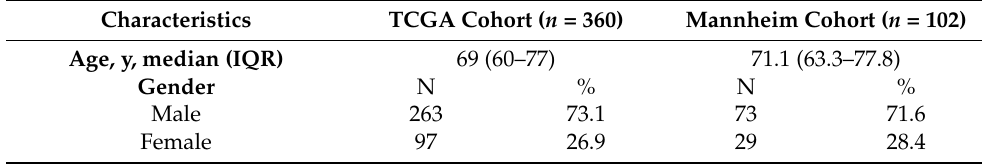
Table 1. Clinicopathological characteristics of the cohorts used in this